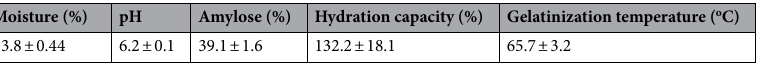
Table 1. Physicochemical characteristics of ginger starch. Results are means ± SD of triplicate determinations.